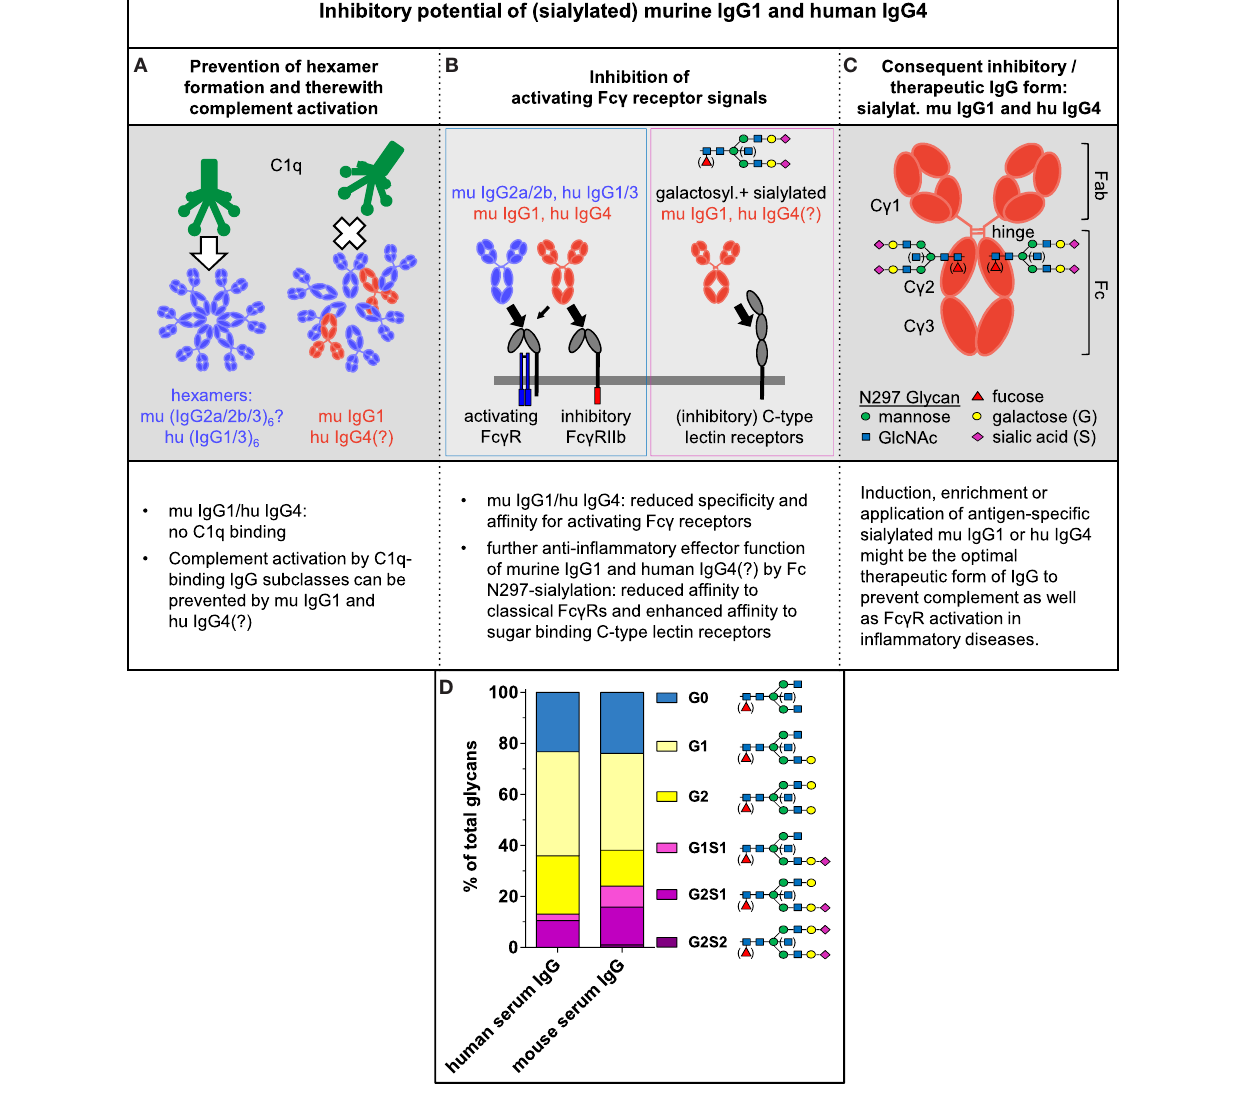
FiGUre 2 | Inhibitory potential of (sialylated) murine IgG1 and human IgG4. (A–c) Summary of our perspective about the inhibitory and therapeutic potential of (sialylated) murine IgG1 and human IgG4 (see text for details). IgG antibodies have one conserved N -glycosylation site at Asn 297 in each of their constant heavy chain regions. The biantennary core glycan structure that consists of four N -acetylglucosamine (GlcNAc) and three mannose residues can be further decorated with fucose, a bisecting GlcNAc and terminal galactose or galactose and sialic acid. (D) Average distribution of total human and mouse serum IgG Fc glycosylation patterns coupled to Asn 297 of total human serum IgG (IVIg; pooled intravenous immunoglobulin from healthy donors) and total murine serum IgG from 8- to 10-week-old untreated female C57BL/6 wild-type mice were analyzed by high-pressure liquid chromatography [data from Epp et al.